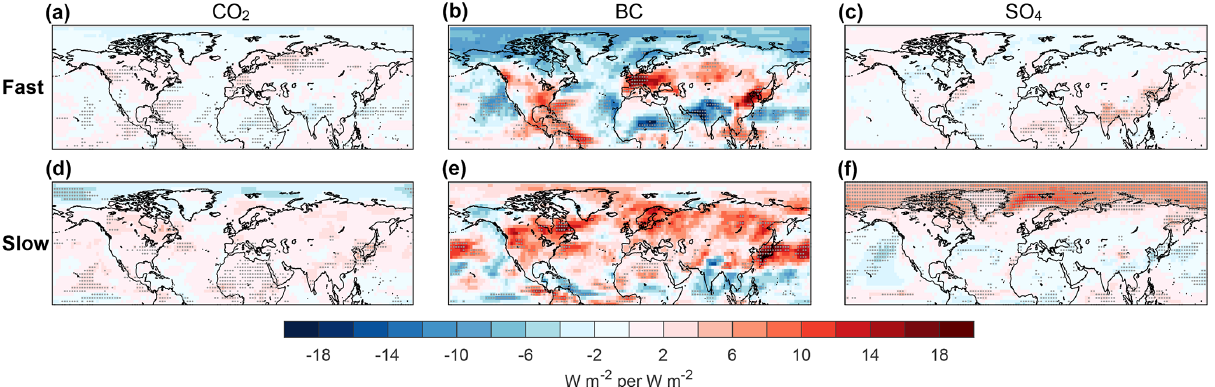
Figure 7. Same as Fig. 2d–f, but for fast (a–c) and slow responses (d–f) of SWCRE changes per unit